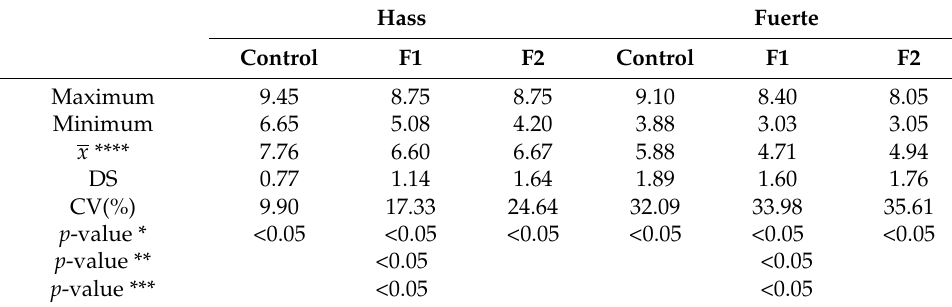
Table 3. Acidity (% citric acid) of control and coated avocados.